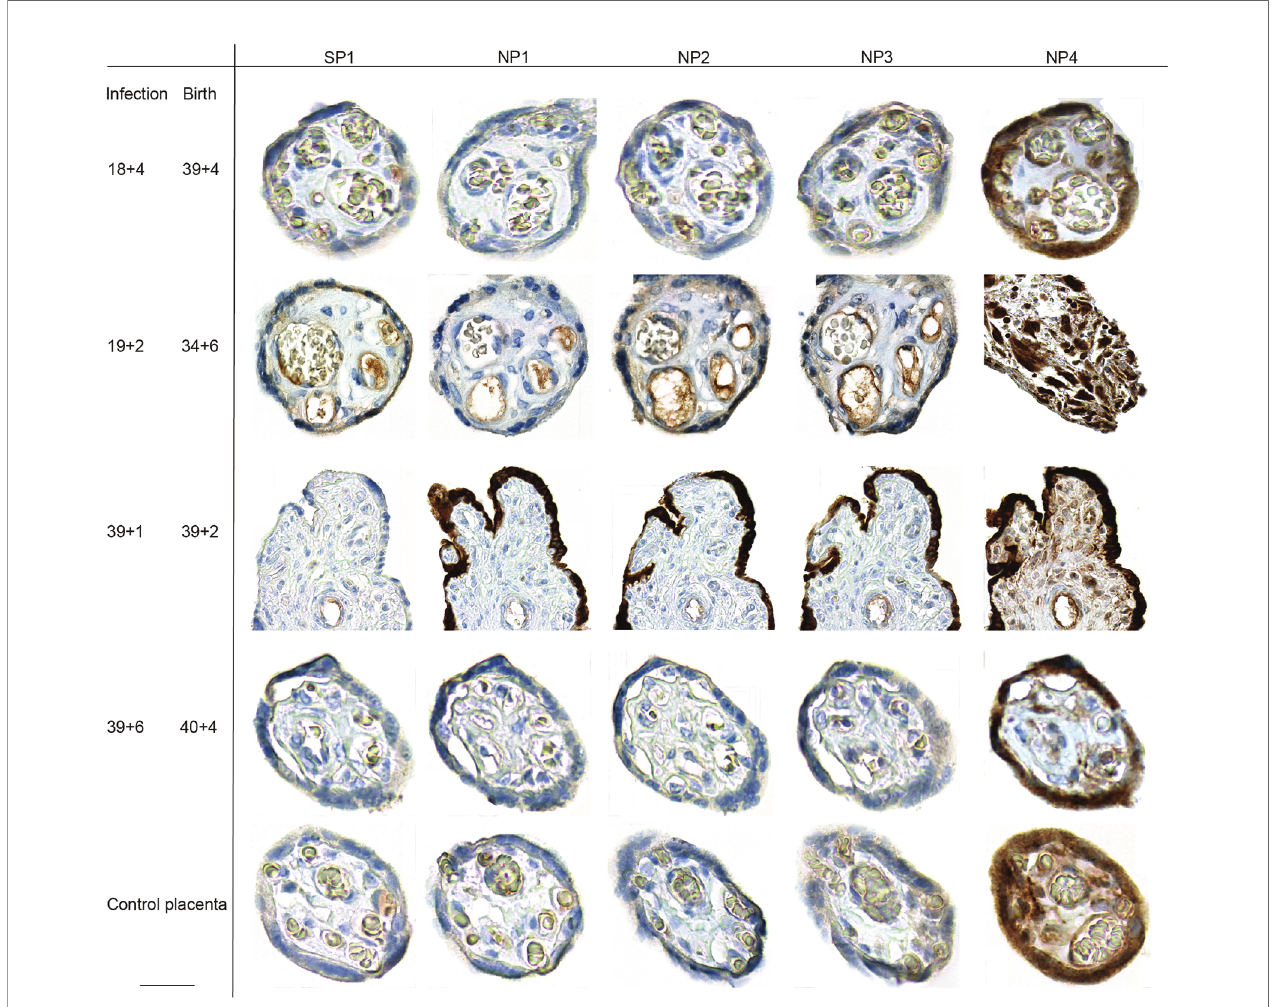
FIGURE 1 | Placental SARS-CoV-2 expression during or upon SARS-CoV-2 infection during pregnancy. SARS-CoV-2 SP and NP expression was assessed by IHC on placental specimen taken at delivery. Time point of infection and delivery is listed at the left side. The antigen targets of the antibodies used for respective IHC, SARS-CoV-2 speci fi c SP or NP, are provided in the top row. Four different antibodies were used to stain for NP, which have been labelled as NP1 to NP4 in top row. One placenta from a non-infected woman was included as control. The third line from the top shows photomicrographs from a positive staining of the syncytiotrophoblast, detected in a placental specimen taken during acute infection (gestation week at infection is 39 + 1 and delivery occurred at 39 + 2). We here deliberately highlight the only positive staining of the sample, additional photomicrographs taken at lower magni fi cation provide a more representative overview of positive staining of the same slide are provided in Supplementary Figure 1 . Bar inserted at bottom left represents 20